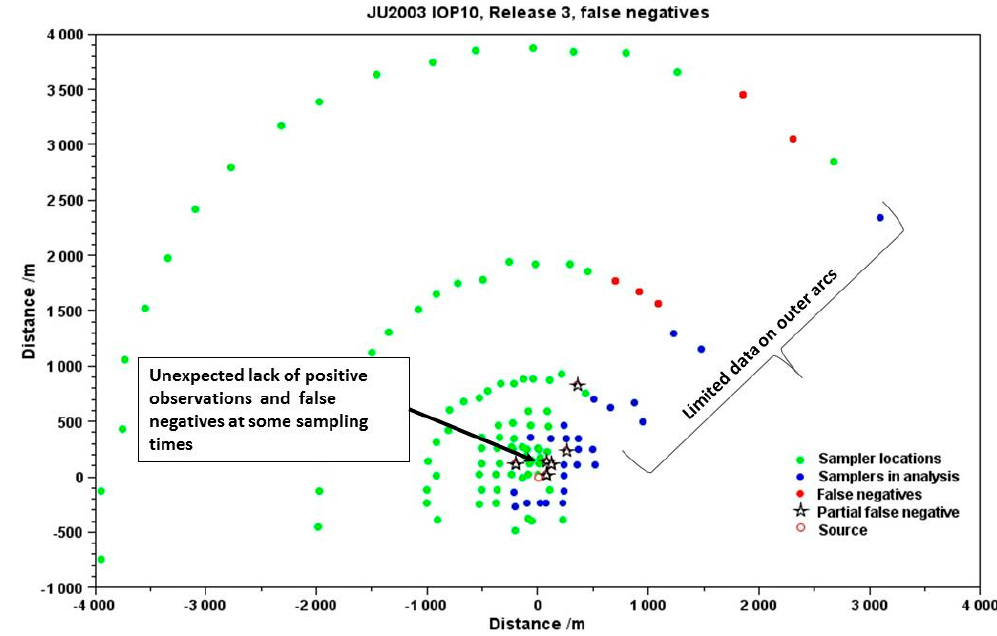
Figure 7. Comparison of UDM prediction with observed sampler data for IOP 10, release 3 of JU 2003. Partial false negatives refer to locations at which the model did not predict positive concentrations at all the time intervals they were recorded at. Adapted from Herring, S. and Huq, P., 2016, 17th International Conference on Harmonisation within Atmospheric Dispersion Modelling for Regulatory Purposes [7].